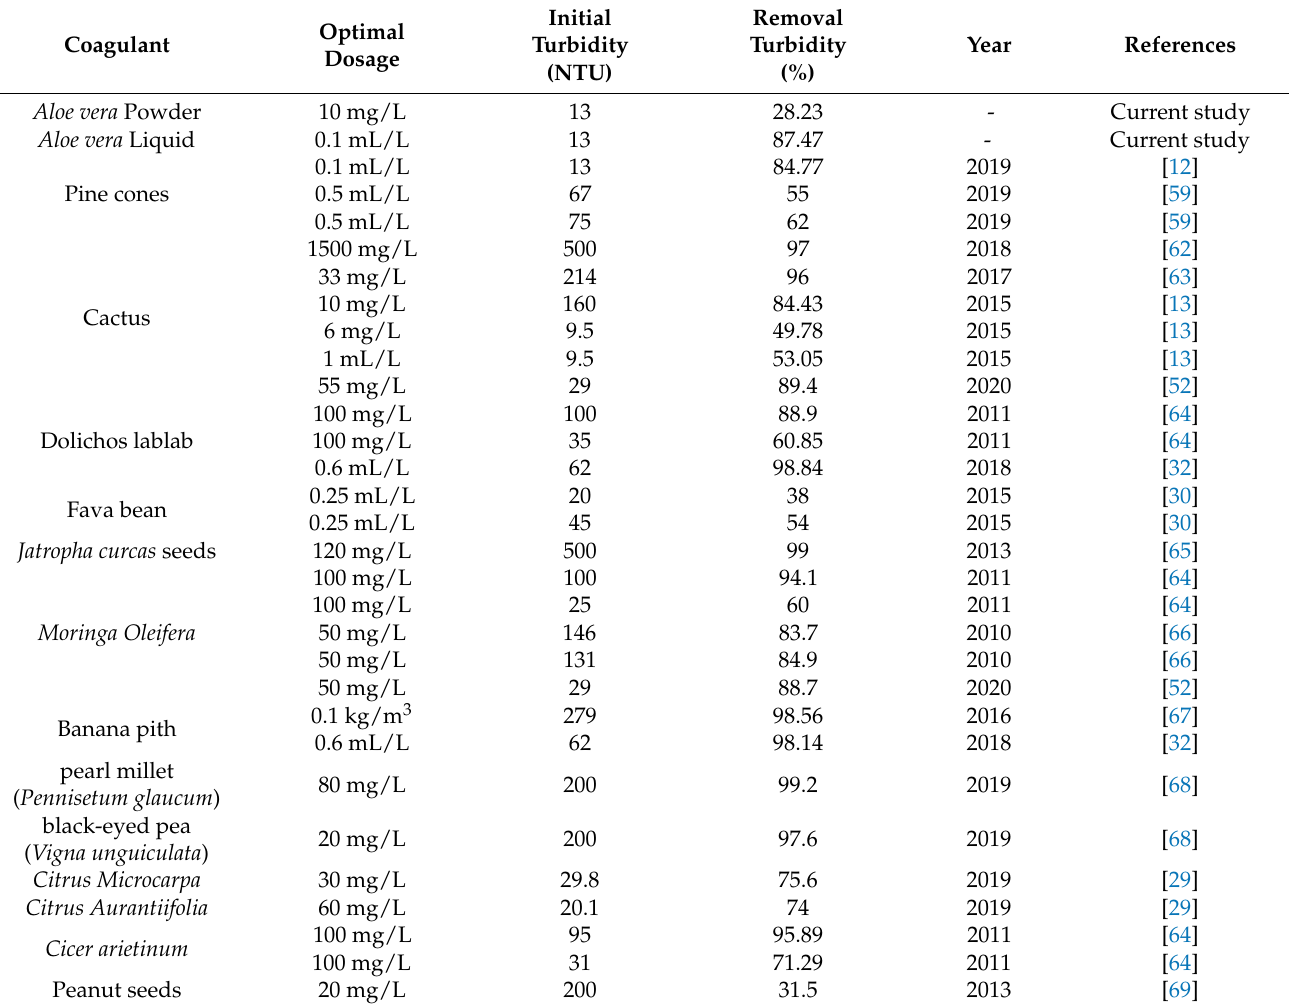
Table 2. Turbidity removal efficiency of different organic